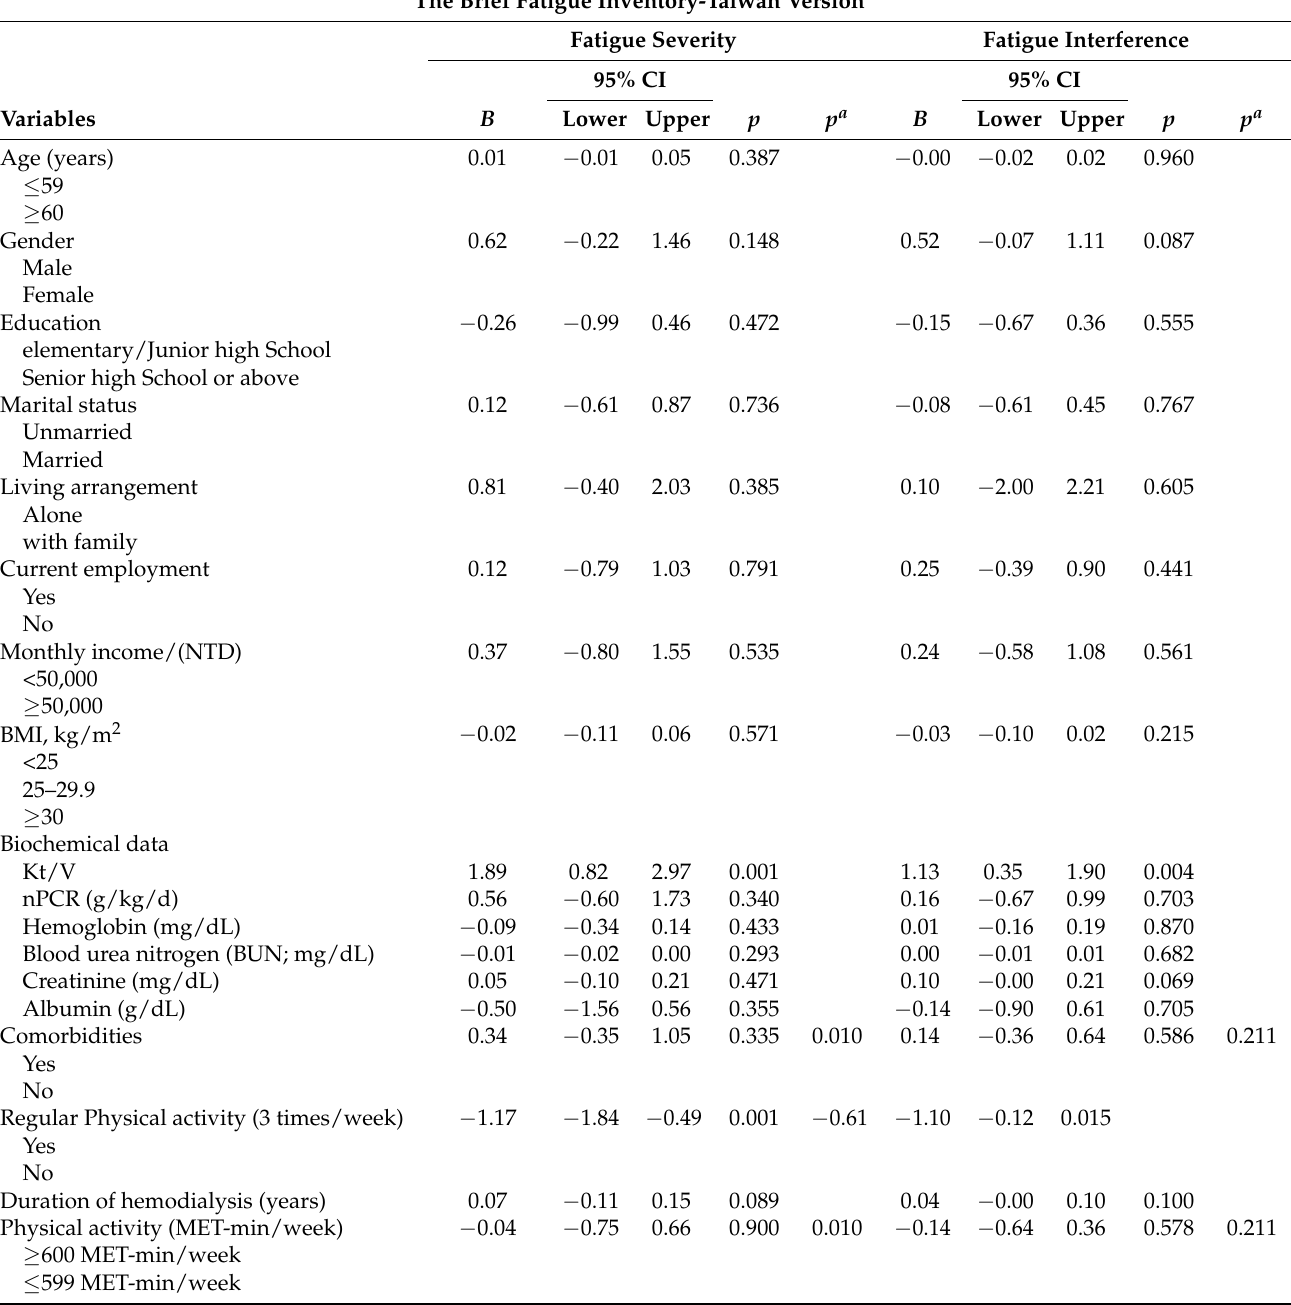
Table 4. Analysis of factors associated with Brief Fatigue Inventory-Taiwan version scores and sociodemographic characteristics ( n =